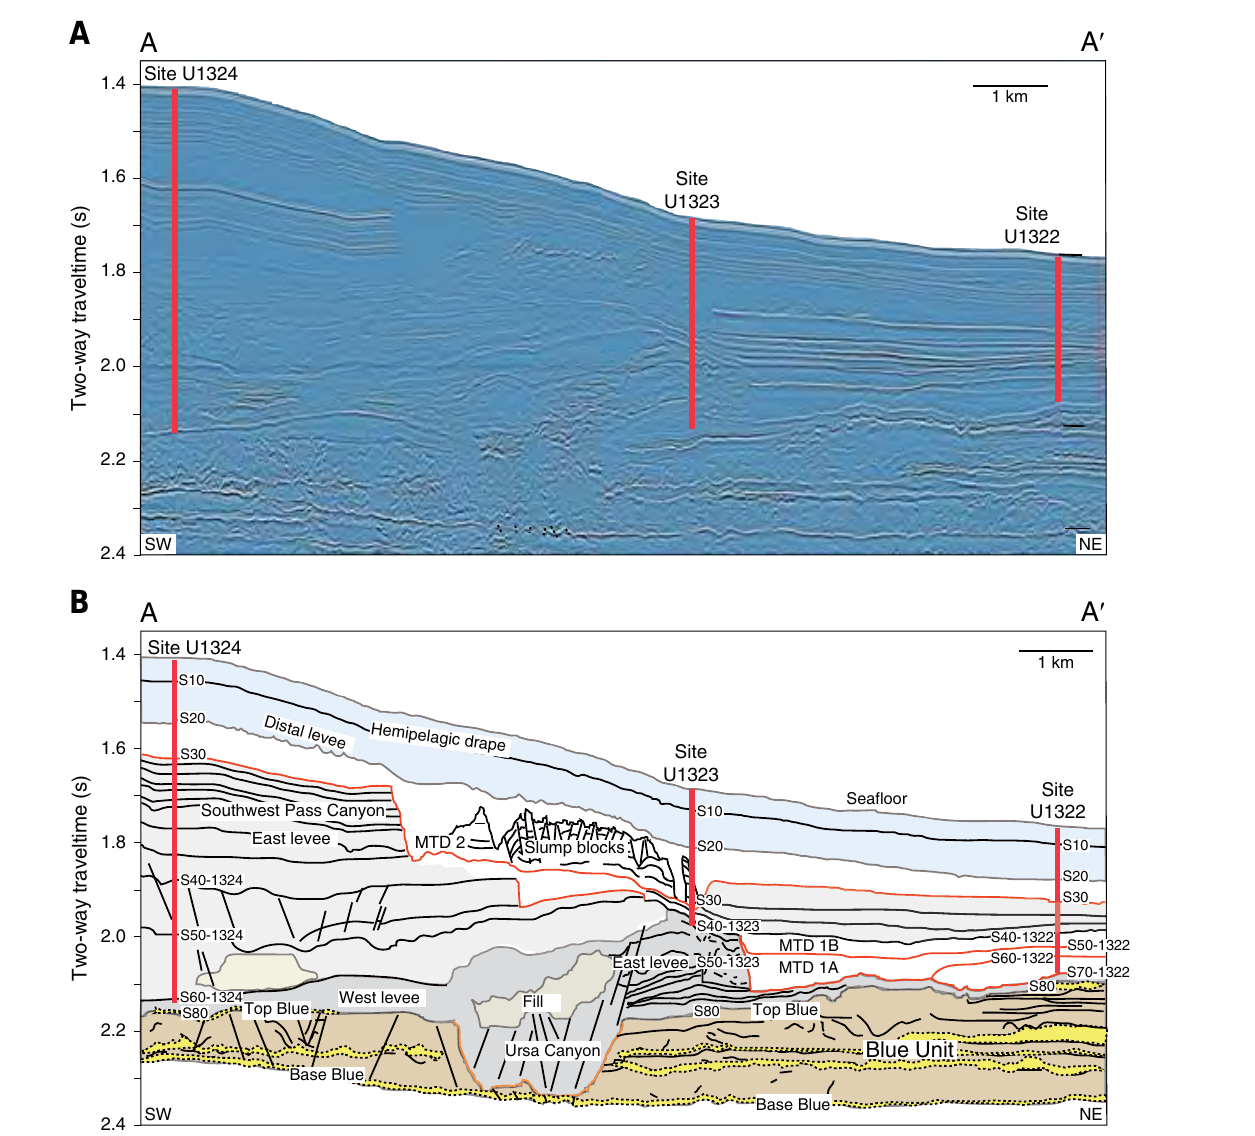
Figure 5. [A] Seismic cross-section A–A’ from Ursa Basin. [B] Interpreted cross-section A–A’. Sand-prone Blue Unit has been incised by channel-levee complex and then overlain by thick and heavily slumped hemipelagic mudstone wedge that thickens westward (left). Blue Unit sands correlate to distinct seismic facies. Thickness of hemipelagic mudstone above Blue Unit does not change signifi cantly in north-south direction. Seismic reproduced with permission of Shell Exploration and Production